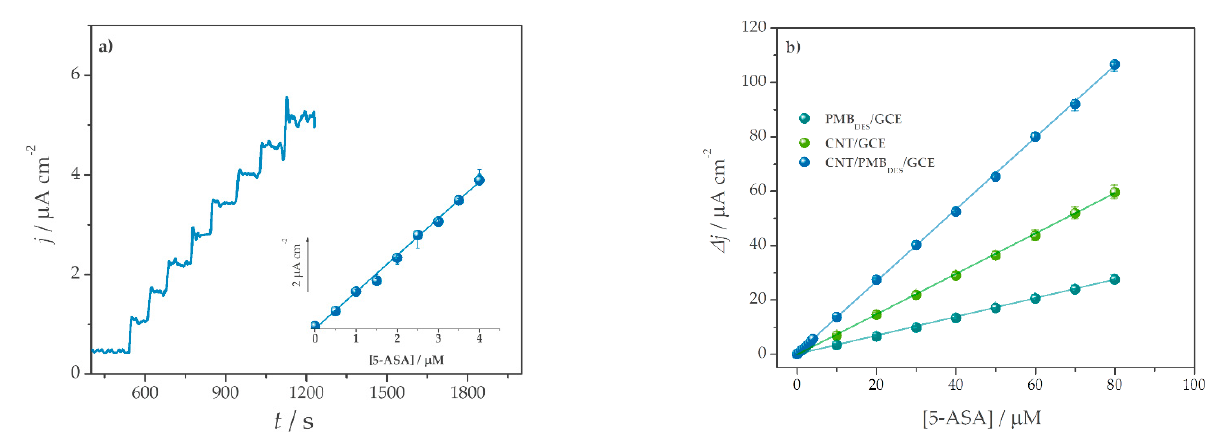
Figure 4. ( a ) CA response ( E app =+ 0.40 V vs. Ag/AgCl) of CNT/PMB DES /GCE sensor for 5-ASA in the concentration range from 0.5 to 4 µ M in 0.04 M BR pH 7.0. Inset, the corresponding calibration plot; ( b ) Calibration plots for 5-ASA determination with PMB DES /GCE, CNT/GCE for 10.0, 20.0, 30.0, 40.0, 50.0, 60.0, 70.0, and 80 µ M 5-ASA and with CNT/PMB DES /GCE for 0.5, 1.0, 1.5, 2.0, 2.5, 3.0, 3.5, 4.0, 10.0, 20.0., 30.0, 40.0, 50.0, 60.0, 70.0, and 80 µ M 5-ASA, respectively.